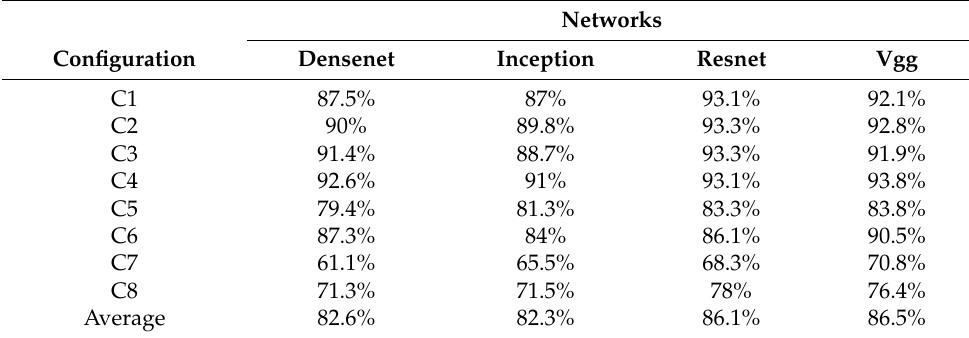
Table 6. Original classification accuracy of each CNN on each of the